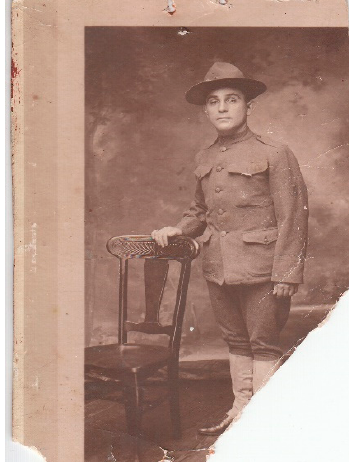
Figure 2. Nickolakis’ first portrait in New York (author ʹ s collection).